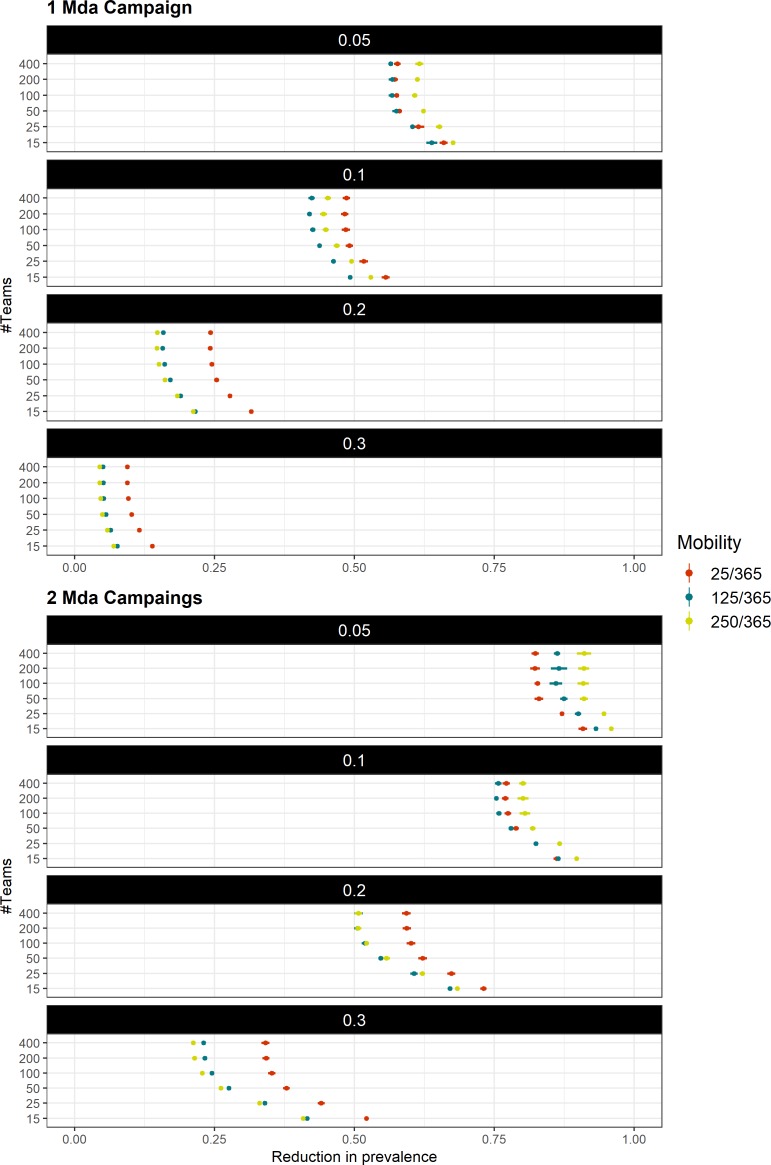
Multivariate model sensitivity analysis independent of transmission heterogeneity.Model outcome (measured as the proportional decrease in parasite prevalence) sensitivity to logistical (Teams – speed of coverage, and number of MDA campaigns), epidemiological (initial mean prevalence in the target area, given in black background over each panel), and behavioral (mobility – daily probability of spending nights in a place other than the habitual residence) parameters. Points and adjacent lines indicate the median and interquantile (5th to 95th) ranges (based on 100 simulations for each parameter set).